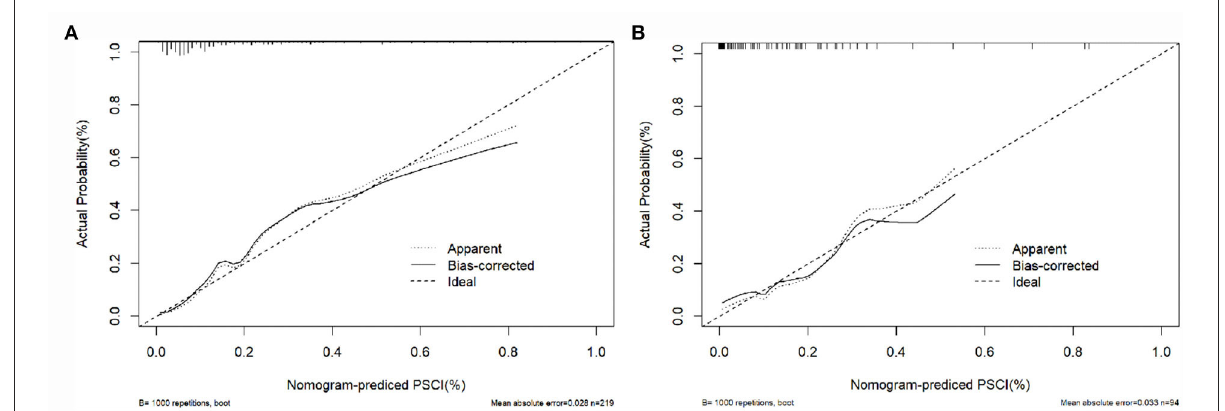
FIGURE3 Calibration curves of the nomogram in the training set and the validation set. (A) The nomogram in the training set ( n = 219); (B) the nomogram in the validation set ( n = 94). The y -axis represents the observed rate of PSCI, and the x -axis represents the nomogram-predicted probability of PSCI. The dotted lines represented by the nomogram are closer to the diagonal gray lines representing a better prediction.